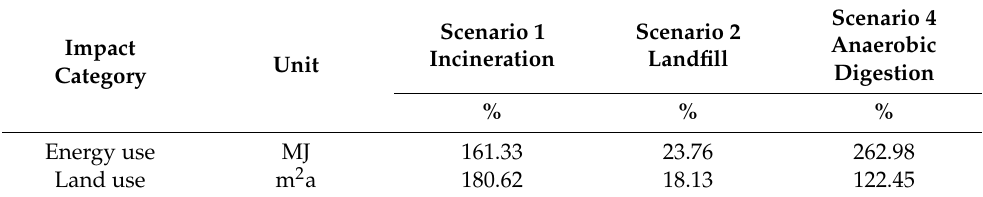
Table 4. The reduction percentage of potential environmental impacts in energy use and land use results of three energy-recovery scenarios after evaluation with avoided